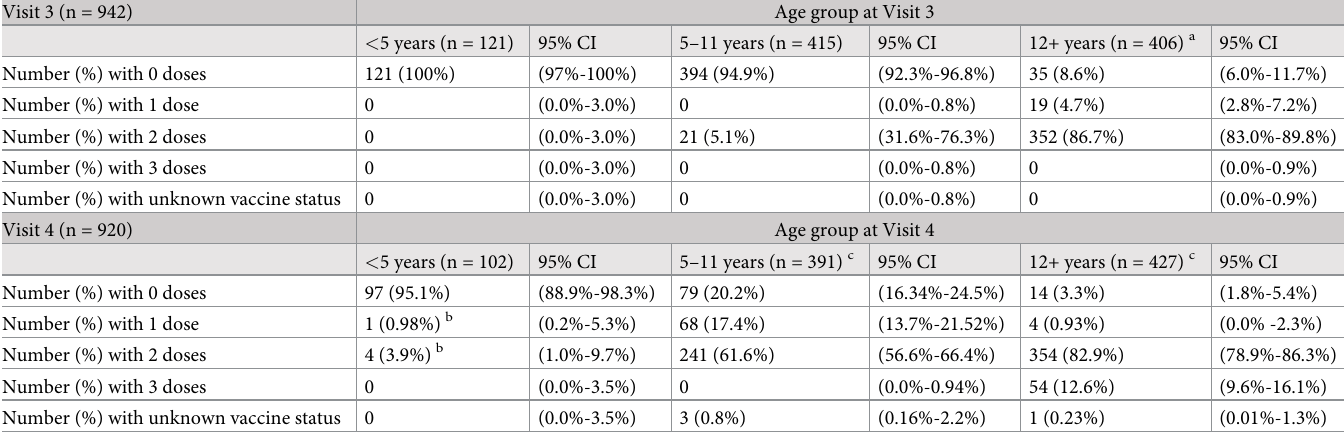
Table 2. Vaccine status of participants at Visit 3 and Visit 4 following approval for ages 11+ prior to V3 and ages 5–11 prior to V4 using age at time of visit (vaccina- tion considered effective day 14+ post-immunization).